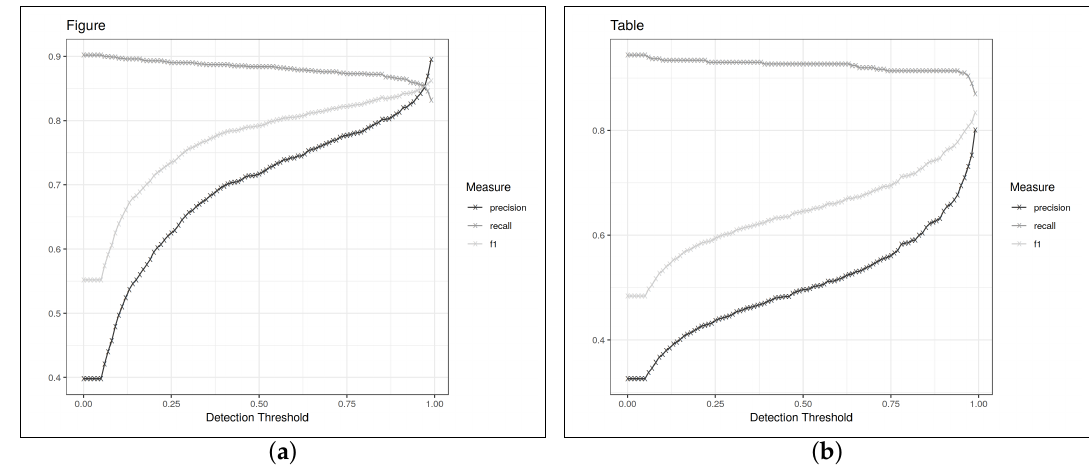
Figure 6. Evaluation scores over different values of the confidence threshold. We can see that recall is almost constant in the interval [0, 97] and then sharply decreases. However, precision steadily increases. We therefore choose a value of roughly 0.97 for the confidence threshold, though the value is slightly different for the two different types of detected elements. ( a ) Figures; ( b )